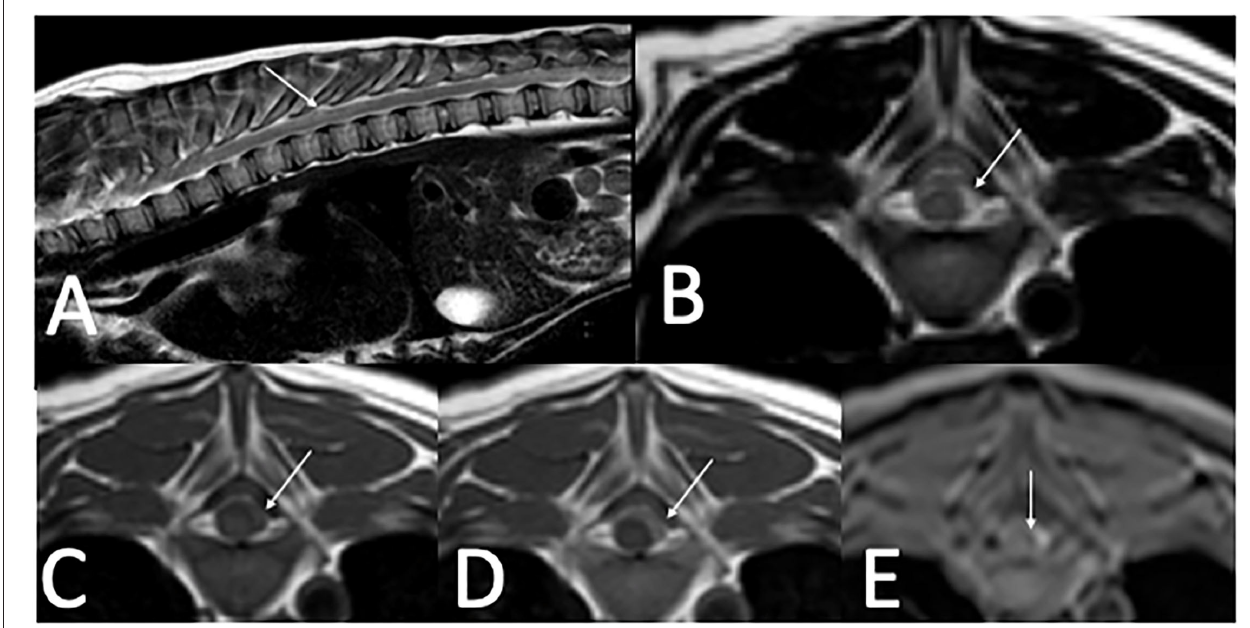
FIGURE 1 | Thoracolumbar MRI in a 4-month-old 4.0kg sexually intact male dachshund with an acute onset of diffuse paraspinal pain and T3–L3 myelopathy (case one). (A) —T2W sagittal image of the thoracolumbar spine showing heterogenous extradural T2 hyperintensity located between T3–T8 (arrow). (B) —T2W transverse image at the level of T8 with T2 heterogenously hyperintense extradural material in the left dorsolateral vertebral canal (arrow). (C) —T1W pre-contrast image at the level of T8 with T1 iso- to hyperintense extradural material in the left dorsolateral vertebral canal (arrow). (D) —T1W post-contrast image at the level of T8 with mild homogenous contrast enhancement of the extradural material in the left dorsolateral vertebral canal (arrow). (E) —T2* image at the level of T8 with hyperintense extradural material in the left dorsolateral vertebral canal and small T2* signal void, consistent with a susceptibility artifact medial to the hyperintense material